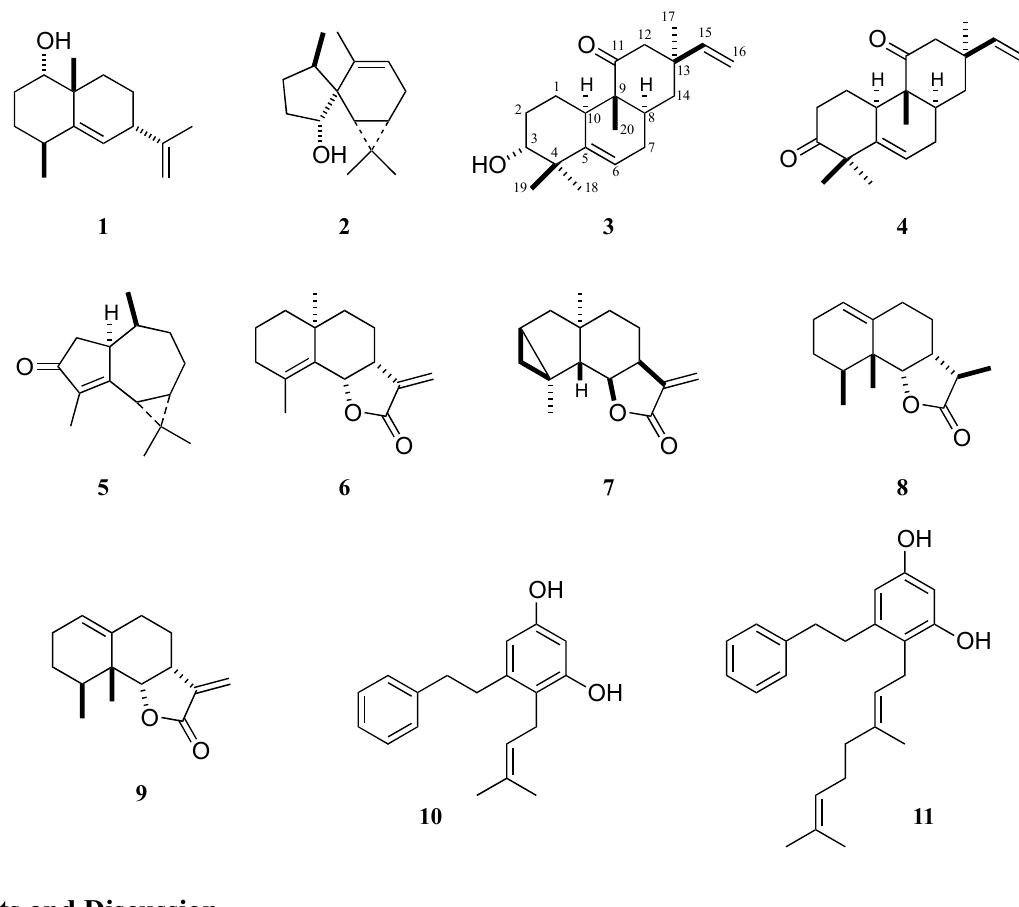
Figure 1. Terpenoids and bibenzyls isolated from Argentine